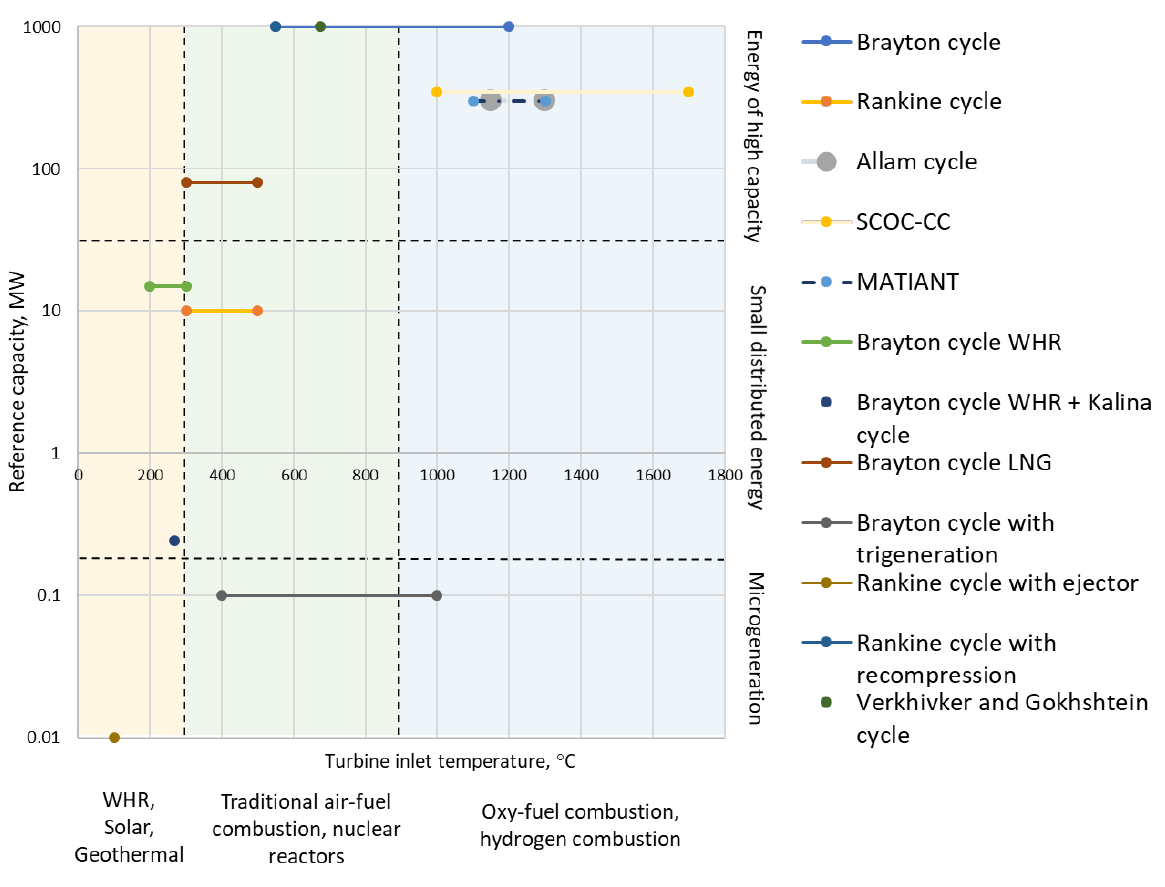
Figure 27. Classification of supercritical CO 2 cycles by power level and temperature at the turbine input.